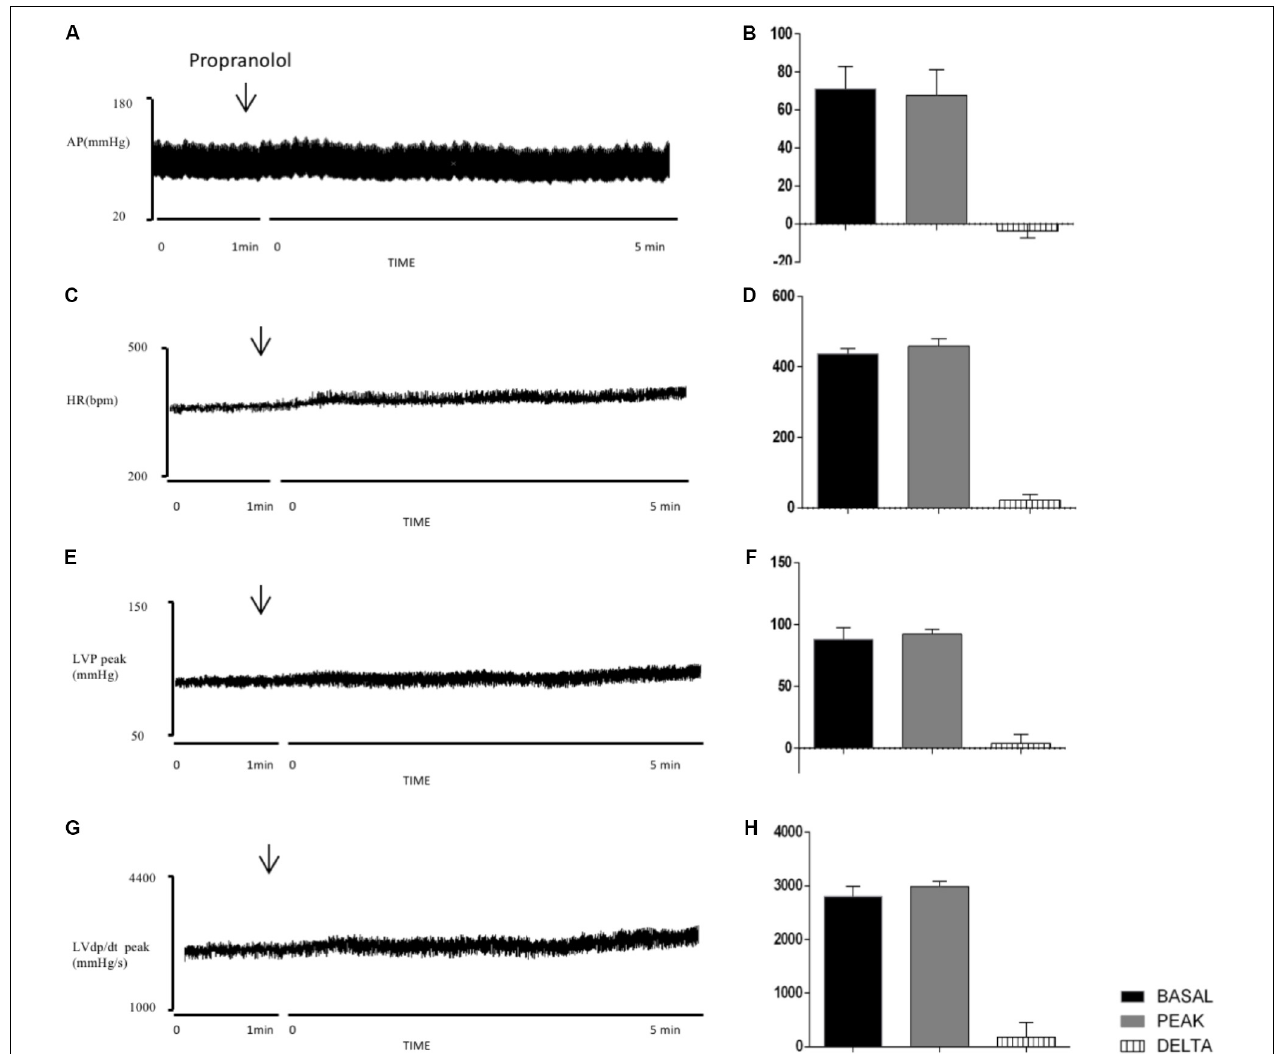
FIGURE 7 | Left column – Records illustrating the responses of MAP (A) , HR (C) , LVP peak (E) , and LVdP/dt peak (G) produced by the unilateral microinjection of propranolol in PVN (arrows indicate the moment of injection). Right column – Mean maximal changes in MAP (B) , HR (D) , LVP peak (F) , and LVdP/dt peak (H) in response to unilateral microinjections of propranolol (100 nl). Values refer to the means collected in the basal period (2 min before the central injection), and at the maximum point of response to microinjection and its variation. ∗ P ? 0.05. MAP, mean arterial pressure; HR, heart rate; LVP peak, maximum pressure in the left ventricle; LVdP/dt peak, first derivative of cardiac left ventricle pressure. n =